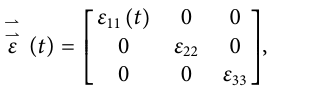
Frontiers in Materials |